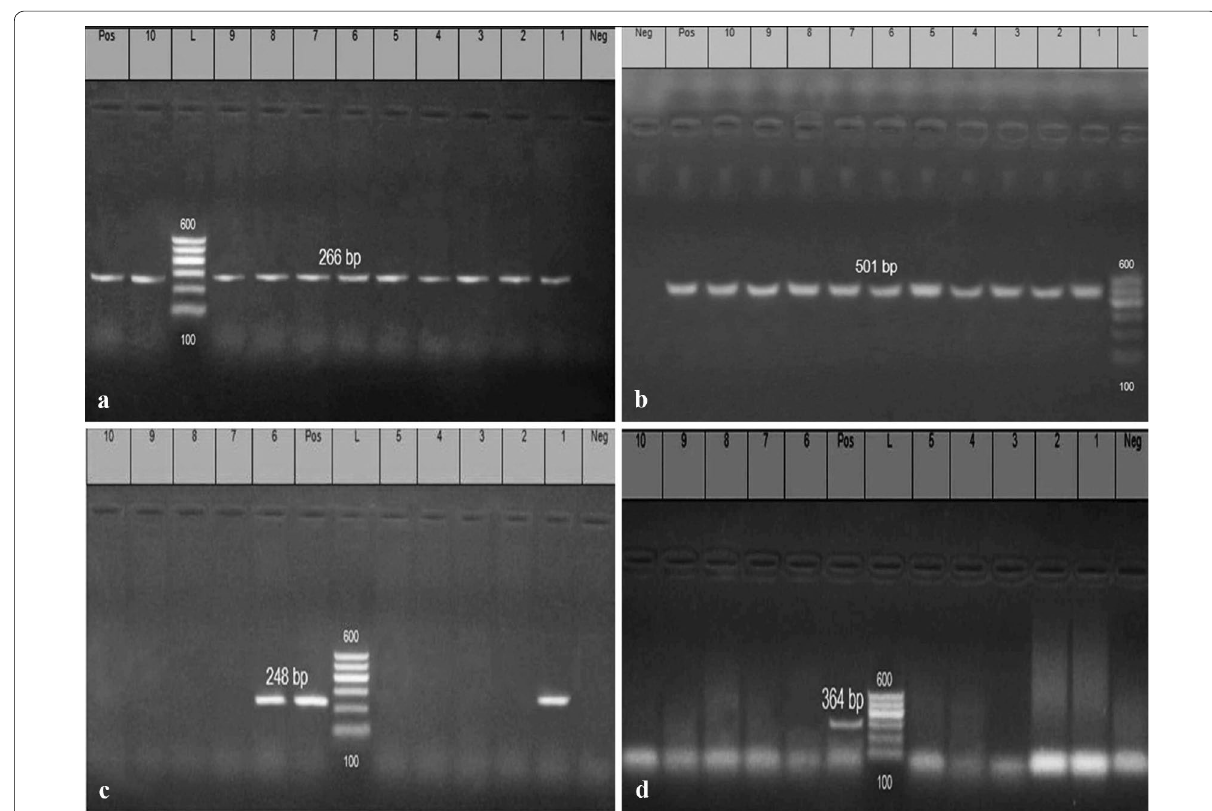
Fig. 1 Electrophoretic pattern of PCR products of E. coli iss, papC, eaeA, and cfaI genes: a (L): the DNA molecular size ladder (Gelpilot 100 bp ladder); (Neg.): negative control; (Pos.): positive control; (lanes 1, 2, 3, 4, 5, 6, 7, 8, 9 and 10): positive amplification of 266 bp of iss gene of different E. coli strains. b (L): the DNA molecular size ladder (Gelpilot 100 bp ladder); (Neg.): negative control; (Pos.): Positive control; (lanes 1, 2, 3, 4, 5, 6, 7, 8, 9 and 10): positive amplification of 501 bp of papC gene of different E. coli strains. c (L): the DNA molecular size ladder (Gelpilot 100 bp ladder); (Neg.): negative control; (Pos.): Positive control; (lanes 1 and 6): positive amplification of 248 bp of eaeA gene; (lanes 3,4,5,7,8,9,10): Negative strains. d (L): the DNA molecular size ladder (Gelpilot 100 bp ladder); (Neg.): negative control; (Pos.): positive control; (lanes 1, 2, 3, 4, 5, 6, 7, 8, 9 and 10): negative amplification of 364 bp of cfaI gene of different E. coli